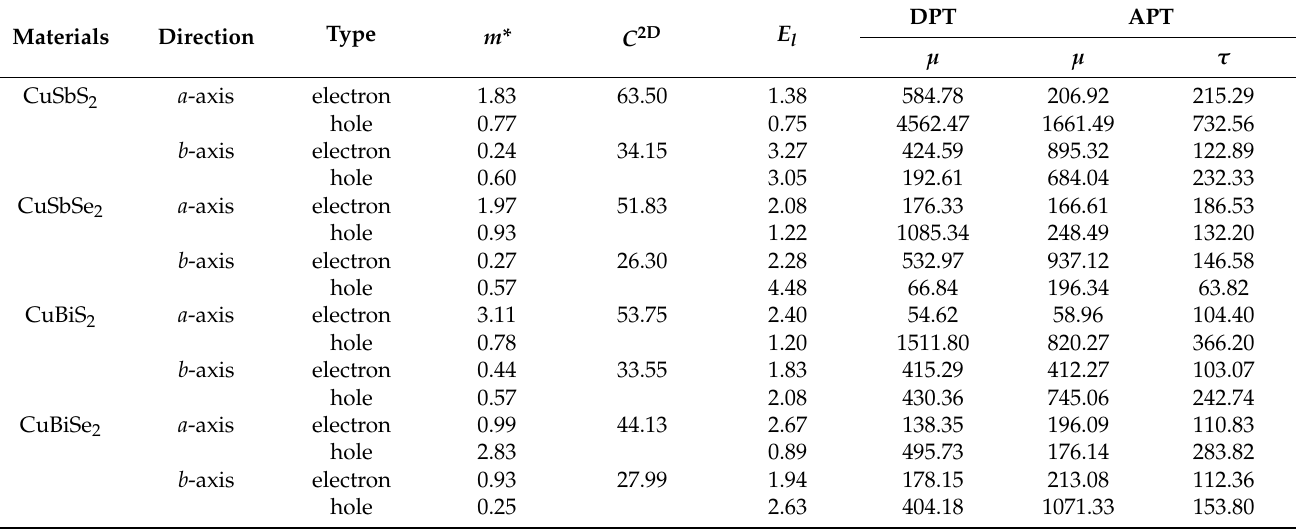
Table 3. The carrier effective mass ( m */ m 0 ), deformation potential constant ( E l /eV), plane